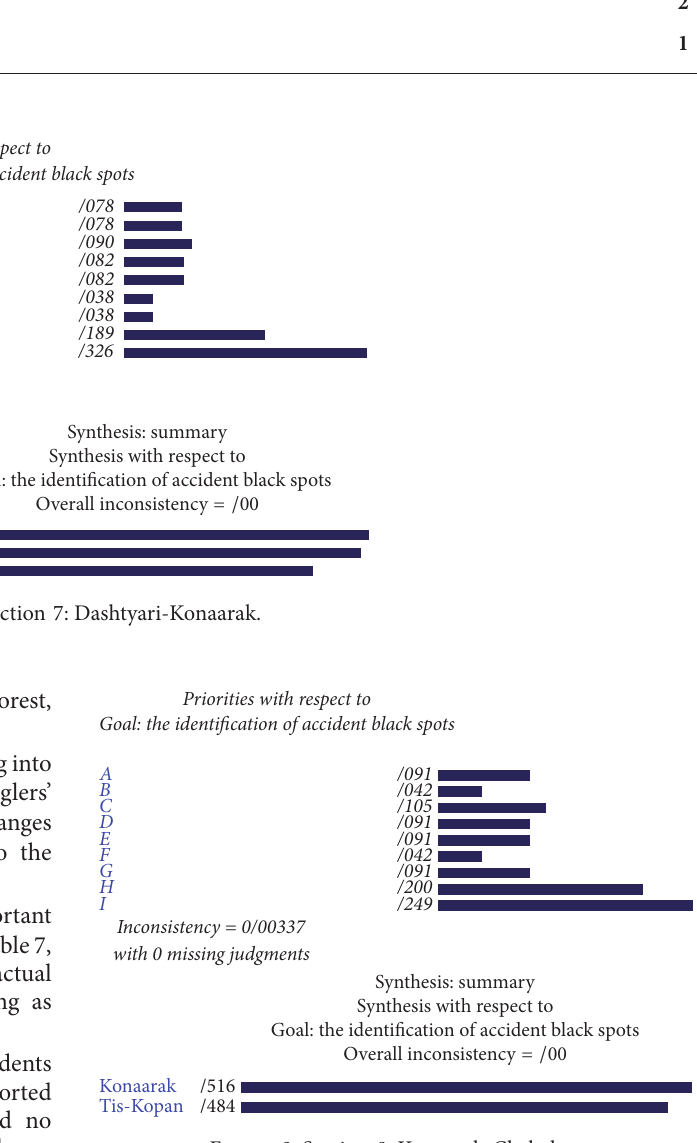
Figure 9: Section 8: